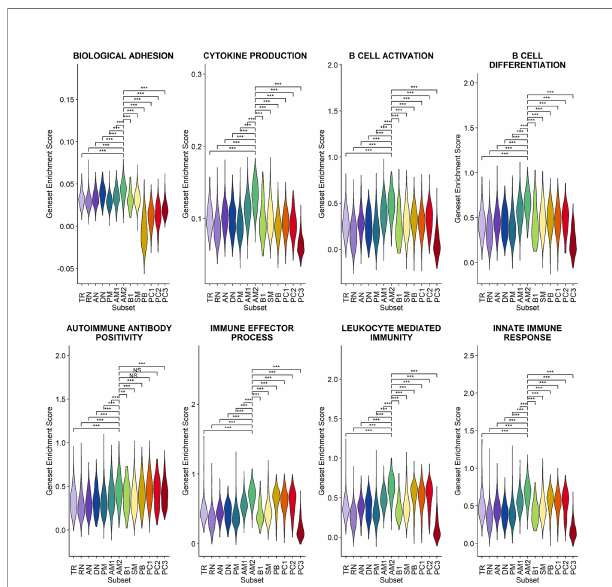
FIGURE 6 | Characterization of AM2 B-cell subsets by gene set enrichment analysis for in fl ammatory functions in comparison with other B-cell subsets. Statistical signi fi cance was calculated by Wilcoxon rank sum test: *** p < 0.0001; ** p < 0.001; * p < 0.01. NS, not signi fi